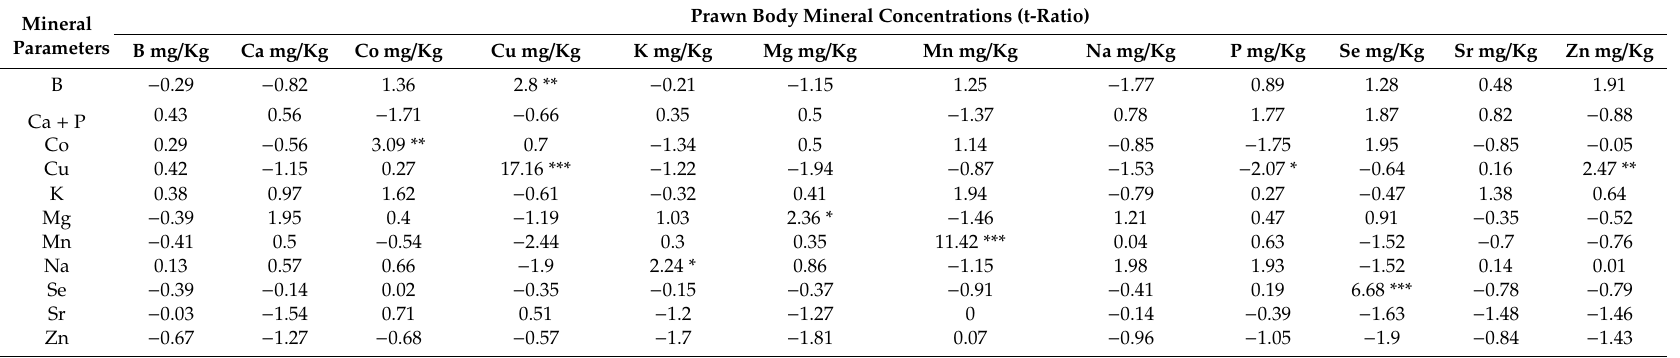
Table A5. E ff ect of dietary mineral inclusions on prawn body mineral concentrations (mg / Kg) using two-level screening analysis. PB statistical values for each mineral is outlined. t-ratios with asterisks (*, **, ***) denote significant p -values defined as * p < 0.05, ** p < 0.01, *** p <